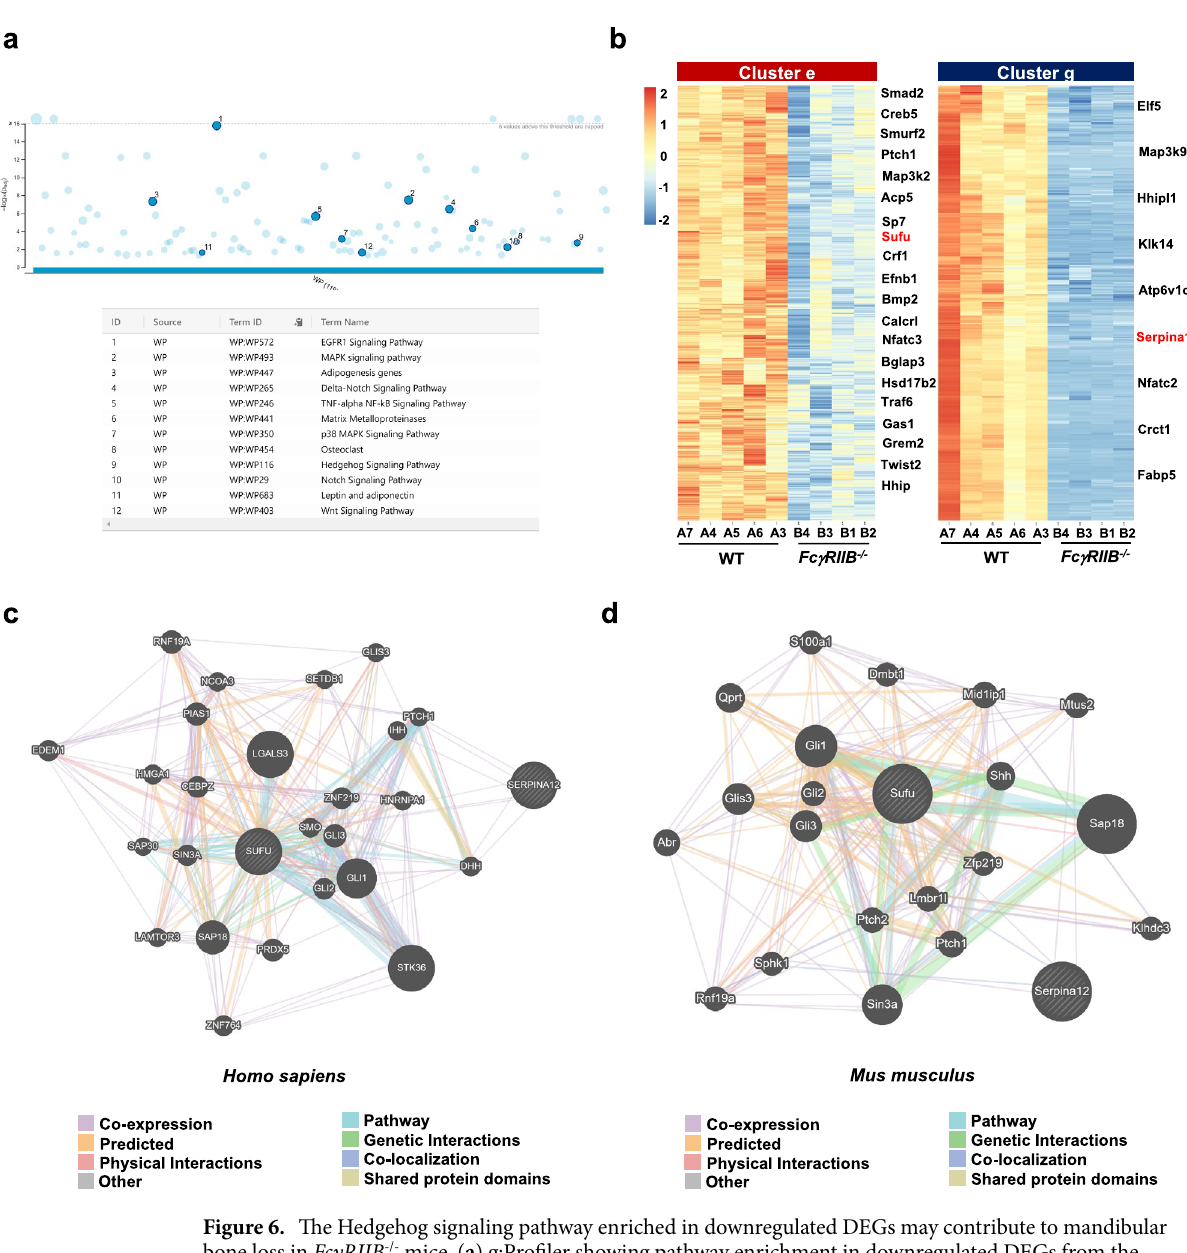
Figure 6. The Hedgehog signaling pathway enriched in downregulated DEGs may contribute to mandibular bone loss in FcγRIIB -/- mice. ( a ) g:Profiler showing pathway enrichment in downregulated DEGs from the WikiPathways. The size of circle represents number of gene counts in each pathway. ( b ) Both Sufu and Serpina12 were expressed in downregulated DEGs as shown in cluster e and g, respectively. ( c ) GeneMANIA network identifying potential interactions with Sufu and Serpina12 associated with Hedgehog signaling pathway in human and ( d ) in mouse. The network was based on the genes retrieved from GeneMANIA by inputting Sufu and Serpina12